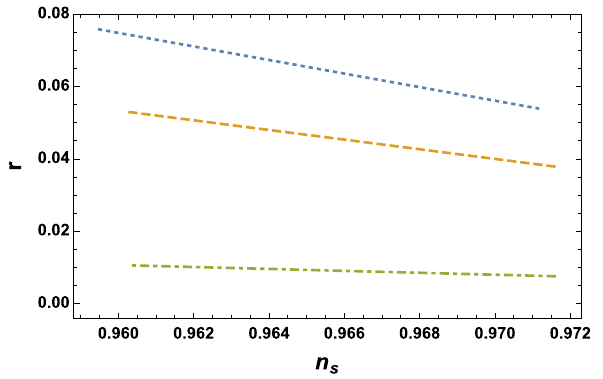
Fig. 12 n s vs r for η = 0 . 2 ,λ = 3 (dotted), η = 0 . 25 ,λ = 10 (dashed) and η = 0 . 35 ,λ = 100 (dot-dashed) in the N - e -fold interval 50 ≤ N ≤ 70. n s increases while r decreases with N . All curves are in the region favored by latest observations